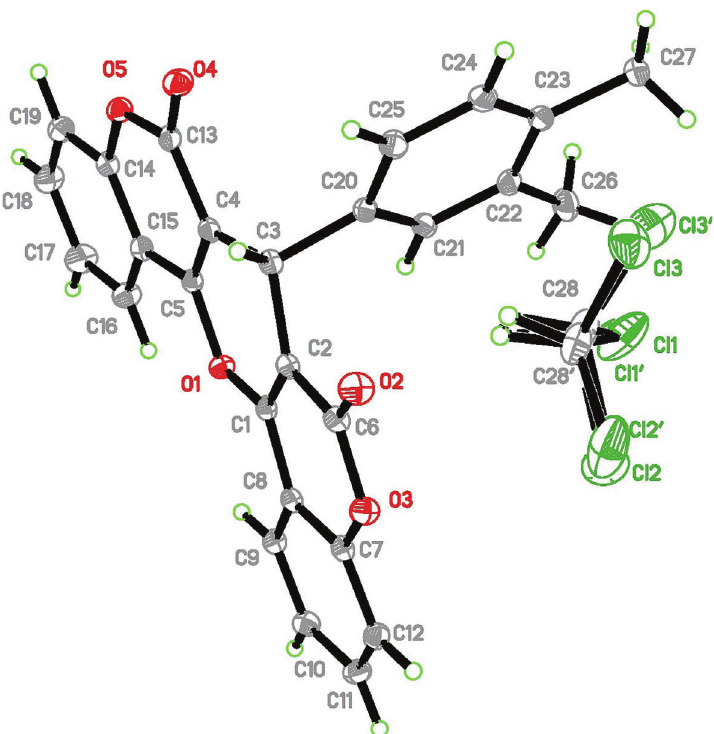
Figure 2. Molecular structure of compound I b.